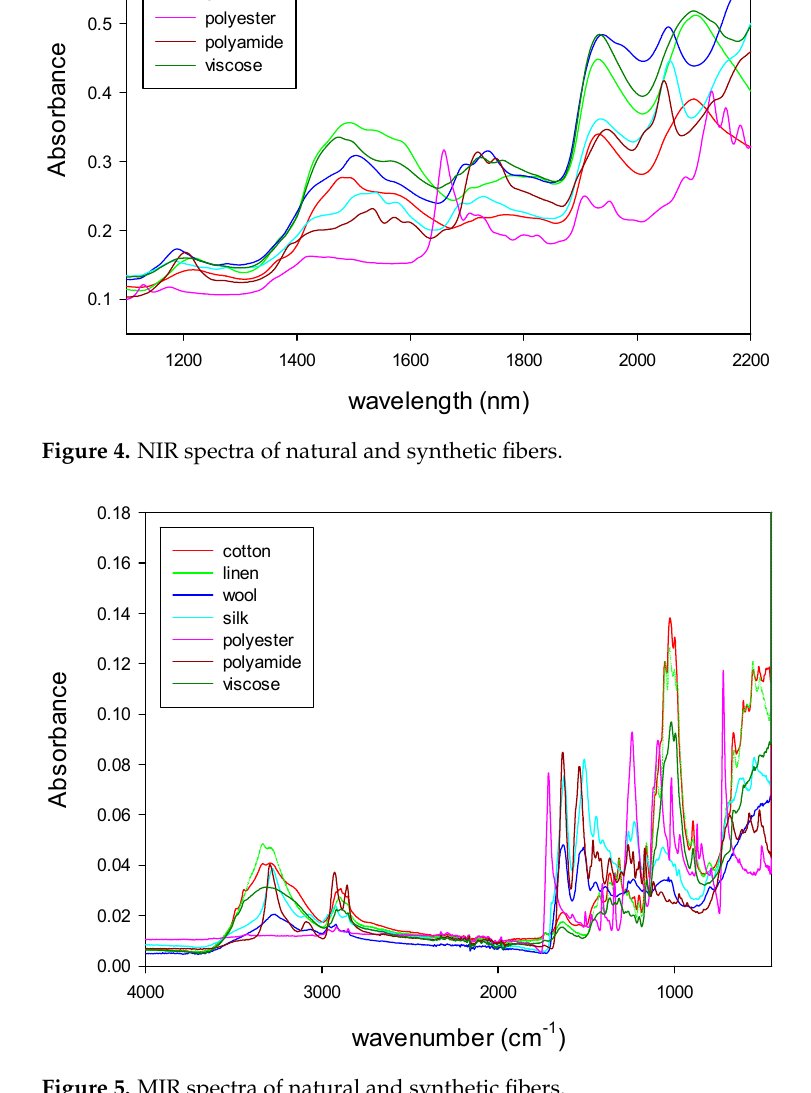
Figure 5. MIR spectra of natural and synthetic fibers. In addition, the NIR and MIR spectra of the binary mixtures of fibers are shown in Figures 6 and 7 (viscose/polyester) and Figures 8 and 9 (cotton/polyester), respectively. When carefully observing those figures, the characteristic bands from both components of the blend could be